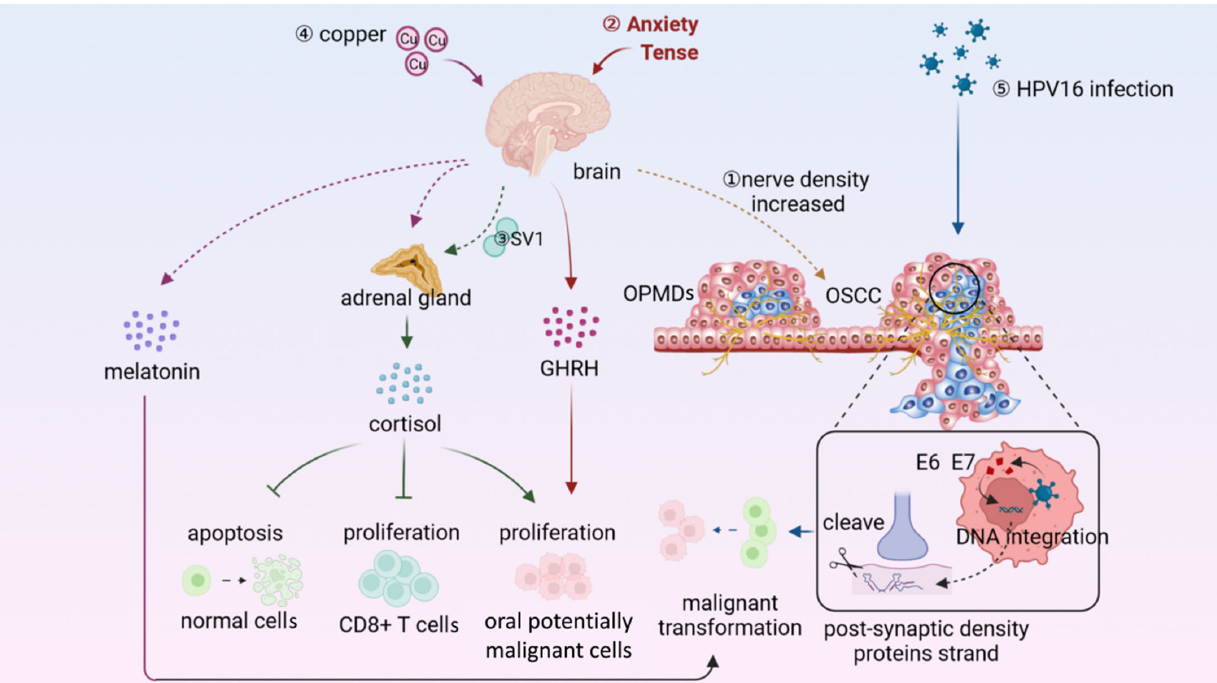
Figure 4. The disturbed neural microenvironment participates in the carcinogenesis of OPMDs. ① The nerve fiber density increases as OPMDs carcinogenesis progresses. ② – ⑤ The external factors, including negative emotion, SV1, Cu, and HPV16 infection, significantly affect the behaviors of both potentially malignant cells and immune cells by neural regulation. The solid arrows represent direct action to the downstream components, while the dotted arrows represent that there are more intermediate multi ‐ step reactions that are not shown. Pointed arrows mean “promote” and blunt ‐ end arrows mean “inhibit”. GHRH, growth hormone ‐ releasing hormone; SV1, splicing variant1; Cu, trace element copper; HPV16, human papillomavirus type 16; E6 and E7, viral proteins.